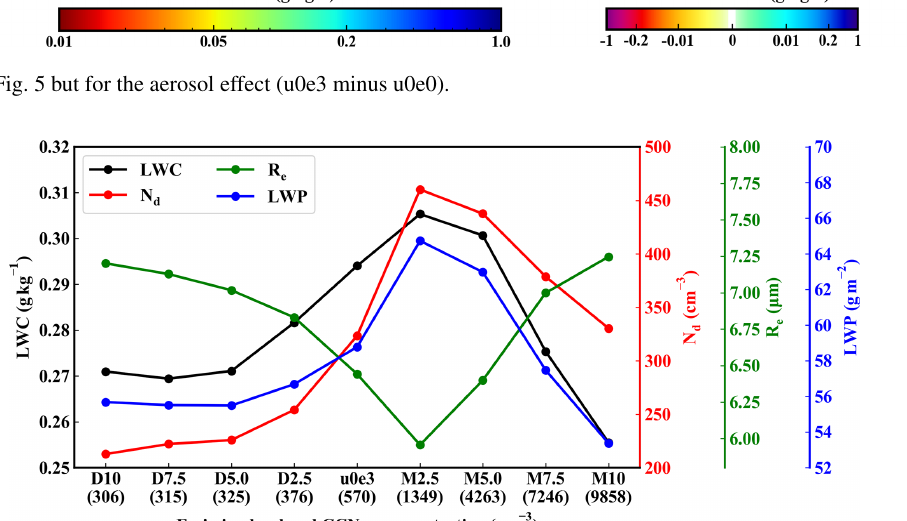
Figure 8. Relationships of the microphysical parameters (LWC, N d , R e and LWP) with emission level and CCN 0 . 1 concentrations. These parameters are the time–height averages (time average for the LWP) in